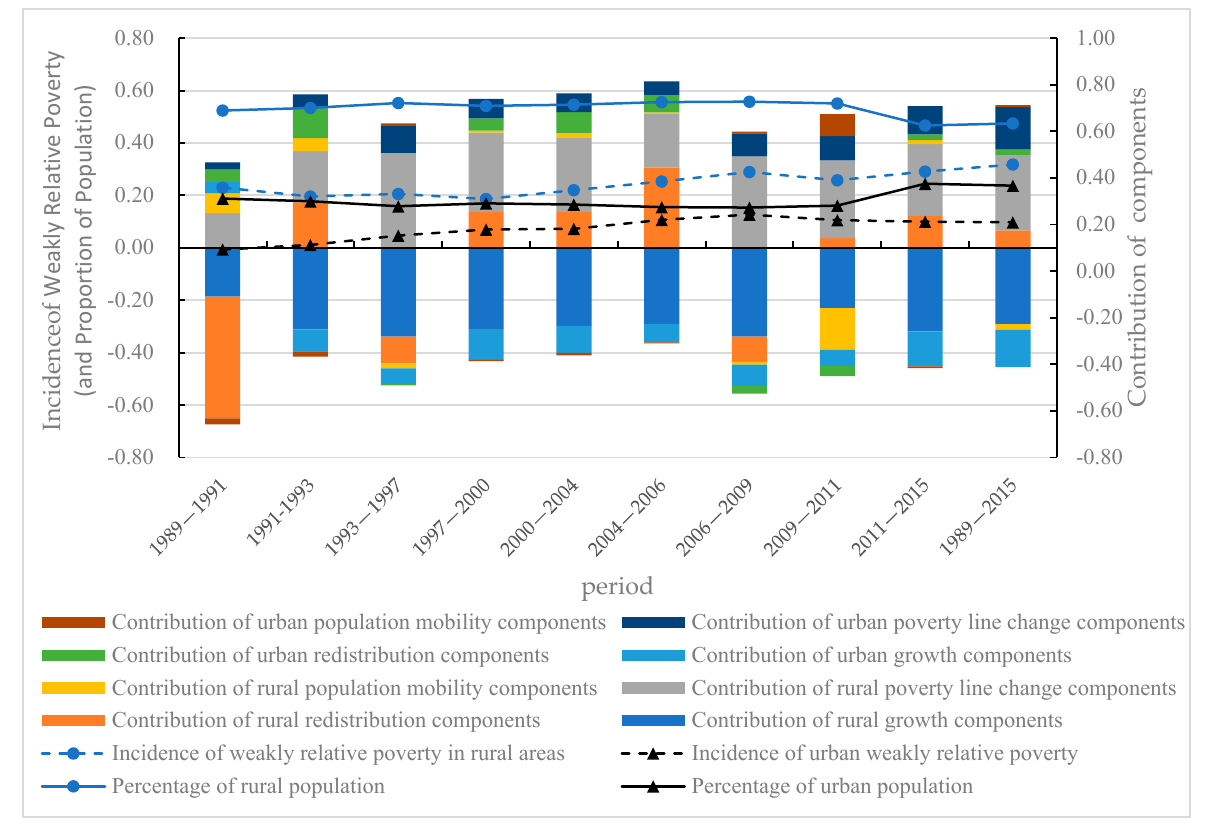
Figure 5. Indicators related to weakly relative poverty in urban and rural areas 7